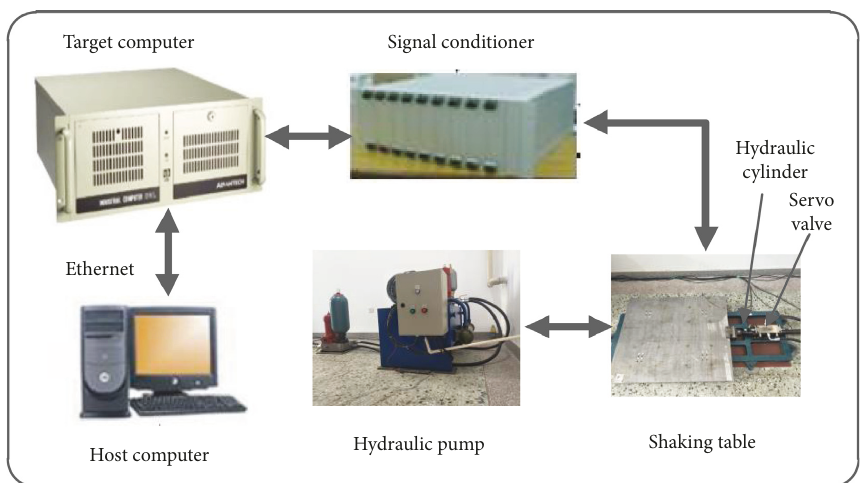
Figure 1: The hydraulic servo shaking table